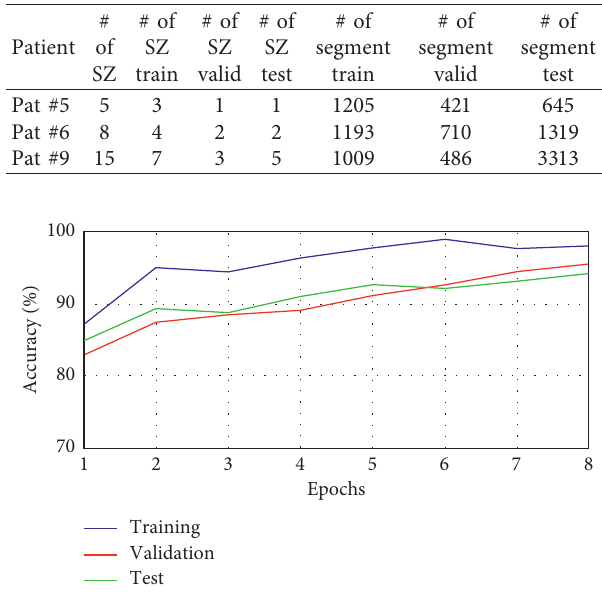
Figure 3: Accuracy on training, validation, and test set for patient #9 against training epochs. Table 3: Test performance (%) of the patient-specific models.